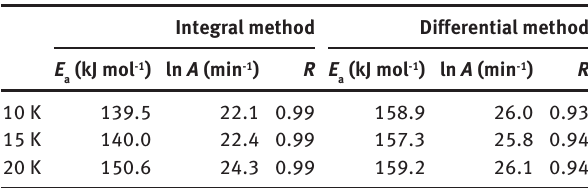
Table 3 Kinetic parameters based on No. 5 reaction model for grafted epoxy resin.